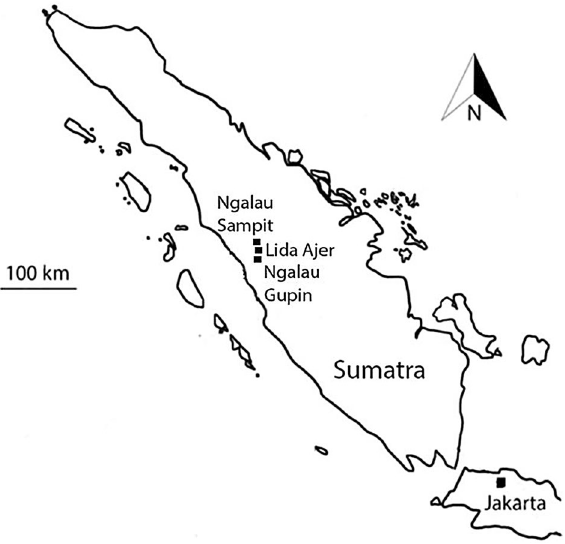
Figure 1. Locality map of the three cave sites in the Padang Highlands, Sumatra.